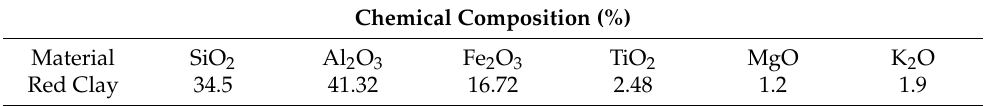
Table 2. Chemical Composition of Red Clay.